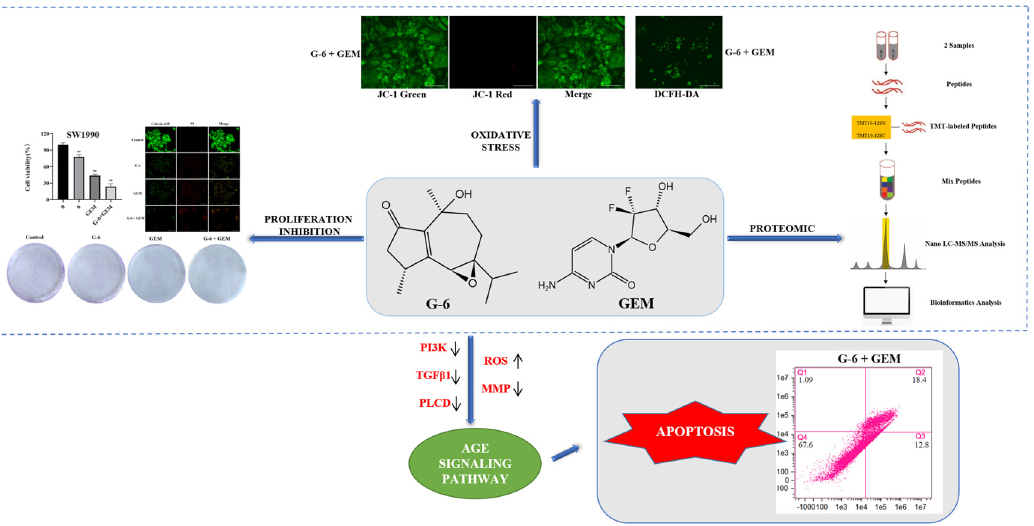
Figure 7. Schematic figure of the cancer inhibition mechanism of G-6 combined with GEM in SW1990 cells.